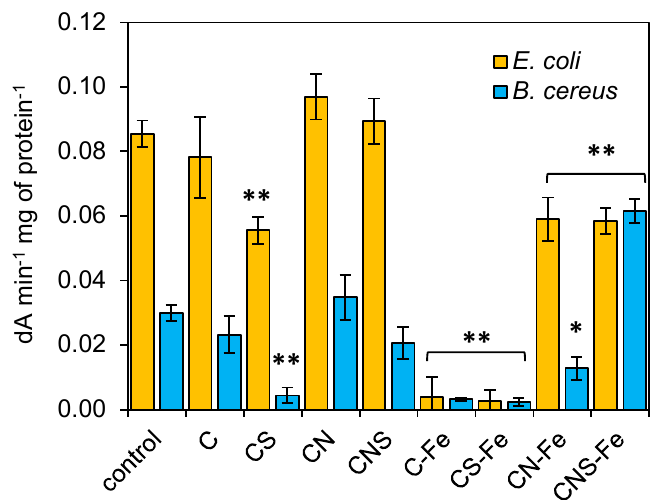
Figure 4. Activity of dehydrogenases after incubation of bacteria with the doped carbons. Significant difference (* at p < 0.1 and ** at p < 0.05) compared to the control and standard deviation are marked.